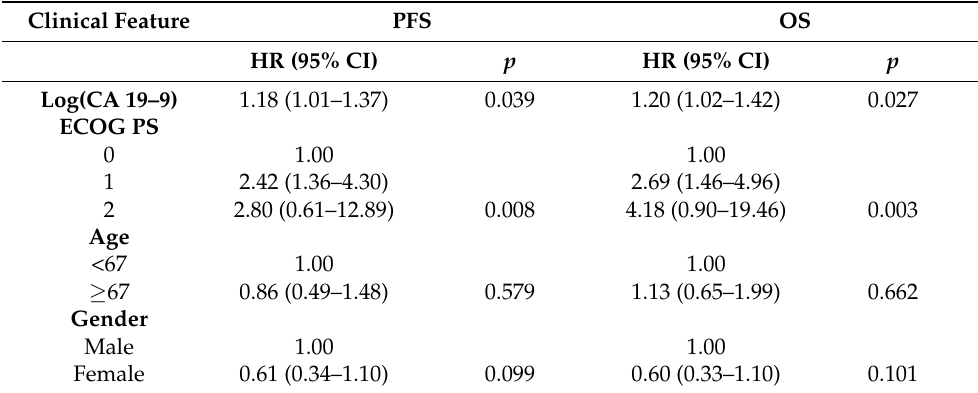
Table 6. Multivariate analysis of progression-free and overall